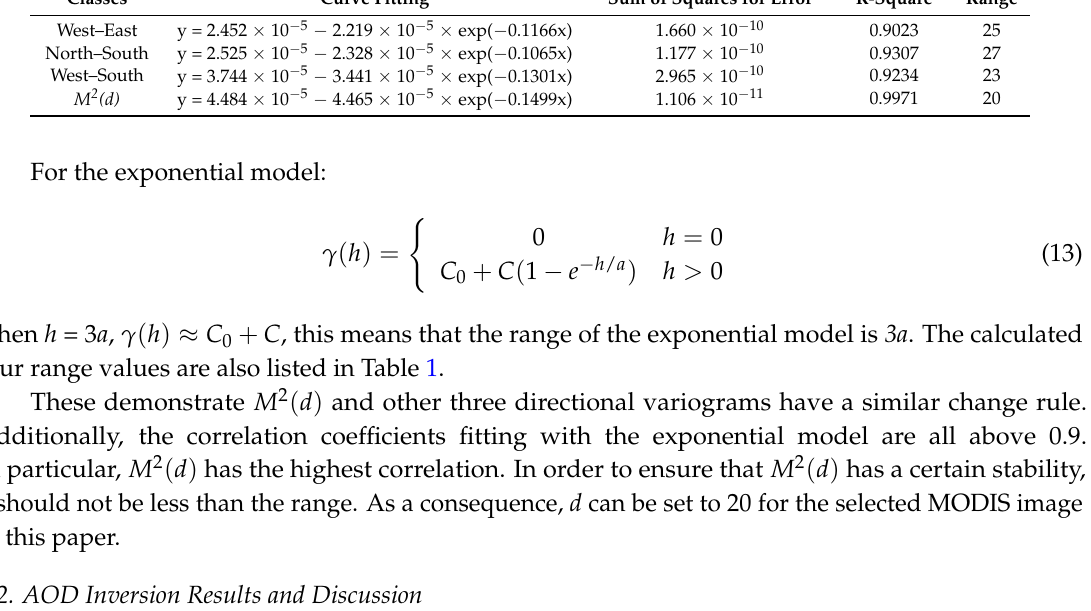
Figure 4. Curve fittings between the variogram and d in four directions: ( a ) West–East; ( b ) North–South; ( c ) West–South; and ( d ) The relationship of M 2 (d) and d . The black dots are the actual calculated variogram value and the blue solid lines are the curve fittings. The variogram model is the exponential model. Table 1. Variogram curve fitting in different directions. The R-square denotes the coefficient of fitting determination. Curve Fitting Sum of Squares for Error